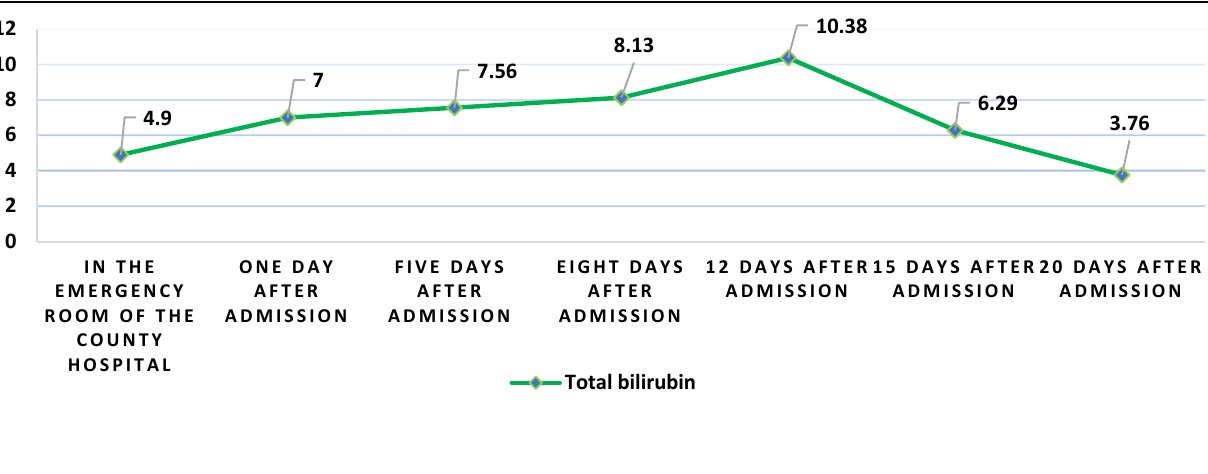
Figure 3. The evolution of total bilirubin levels during hospitalization.